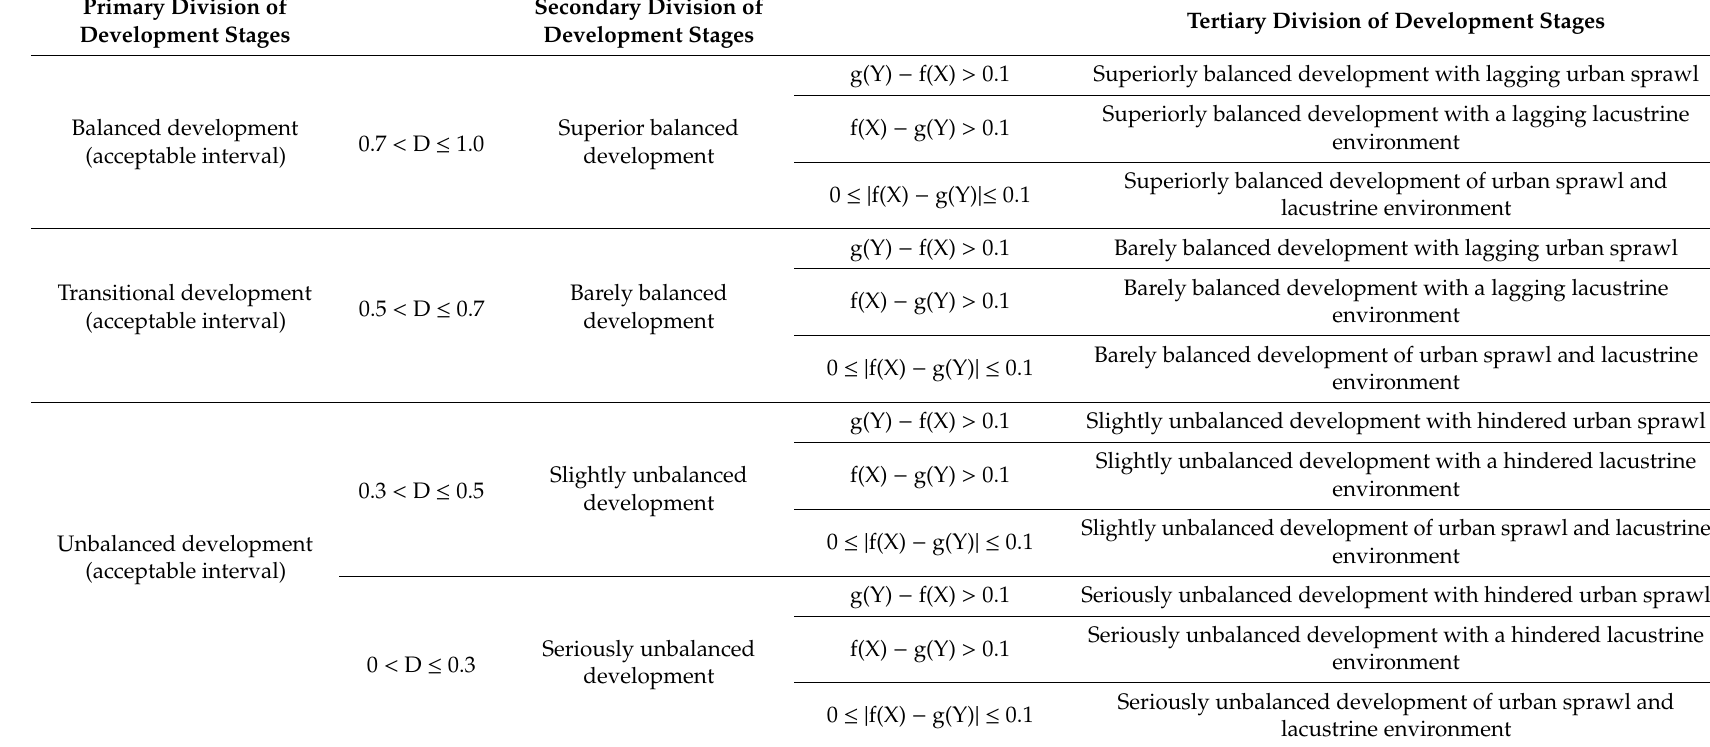
Table 4. Coordination degree of coupling between urban expansion and lake